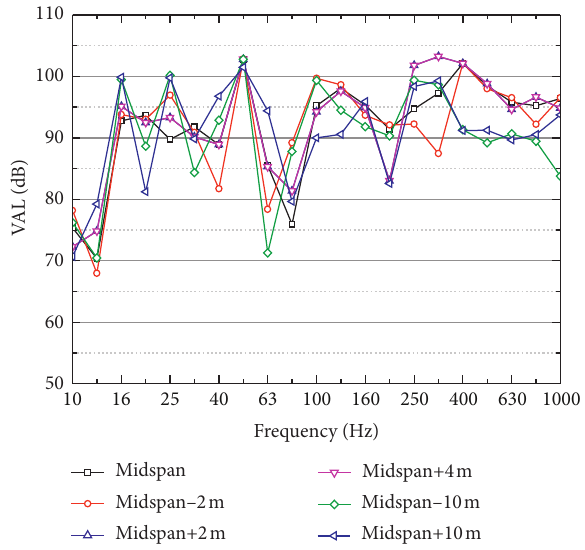
Figure 17: Longitudinal distribution of the VAL.